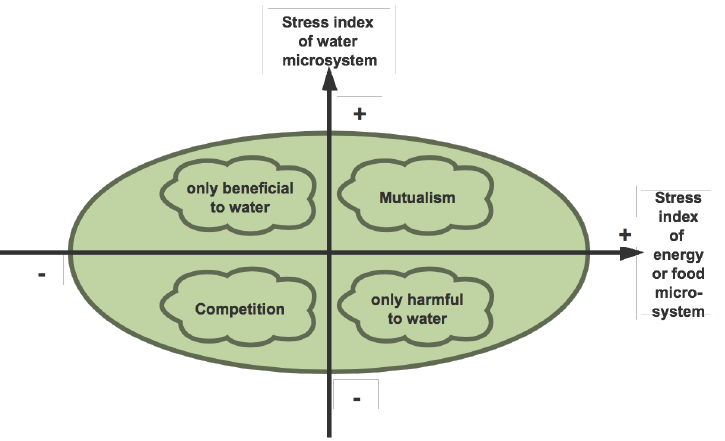
Figure 4. The model of symbiotic coordination relationship between water microsystem and energy or food microsystem. Due to the high complexity of the water-energy-food symbiosis system involved in water security, we cannot quantitatively judge the pros and cons of a symbiosis relation- ship with a single symbiotic security index, and we need to introduce another symbiotic security index, symbiotic index S i ( k ) , to comprehensively judge the water security state of the basin from the perspective of water-energy-food symbiosis (see Figure 5 for details). According to Equations (10) and (11), combined with the arithmetic mean and geometric mean inequality, the value range of the symbiotic index S i ( k ) is [ - √ 2, √ 2 ] . Moreover, the larger the value of S i ( k ) , the better the symbiotic state will be, and then the symbiotic relationship will tend towards a mutually beneficial symbiotic state; the smaller the value of S i ( k ) , the worse the symbiotic state will be, and then the symbiotic relationship will tend towards a competition state. When S i ( k ) = 1 , the symbiotic relationship is in a favora- ble symbiotic state. At this time, the contour of the symbiotic index S i ( k ) = 1 is the thresh- old line of symbiotic security, which is the threshold for entering the symbiotic green se- curity zone; when S i ( k ) = 0 , the symbiotic units are in a state of unprofitability. At this time, the contour of symbiotic index S i ( k ) = 0 is the bottom line of symbiotic security, which is the threshold for entering the safe zone. According to the model of symbiotic coordination relationship between water microsystem and energy or food microsystem, the pattern that is only beneficial to the water microsystem will become the pattern that is only beneficial to the water microsystem strongly after entering the safe zone ( S i ( k ) ∈ (0, √ 2) , that is, S WN ( k ) +S NW ( k ) ≥ 0 ). The pattern that is only harmful to the water microsystem will become the pattern that is only harmful to the water microsystem weakly after entering the safe zone. The pattern that is only beneficial to the water microsystem will become the pattern that is only beneficial to the water microsystem weakly after entering the risk zone ( S i ( k ) ∈ [- √ 2,0) , that is, S WN ( k ) +S NW ( k ) ≤ 0 ). The pattern that is only harmful to the water microsystem will become the pattern that is only harmful to the water microsystem strongly after entering the risk zone. What is more, whether the pattern that is only bene- ficial to the water microsystem is strong or weak depends on the size relationship between the positive effect of the other microsystem on the water microsystem and the negative effect of the water microsystem on the other microsystem. It is strong if the former is